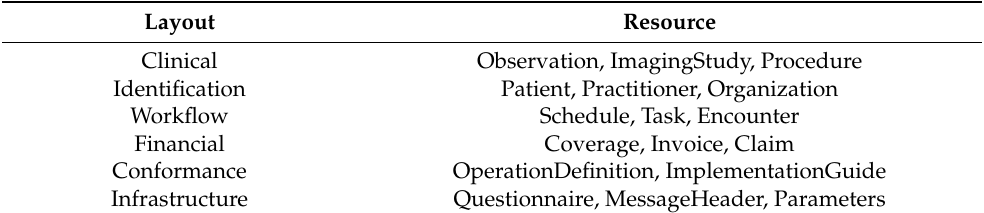
Table 1. Resources for Health Level Seven (HL7) Fast Healthcare Interoperability Resources (FHIR) Layouts. Layout